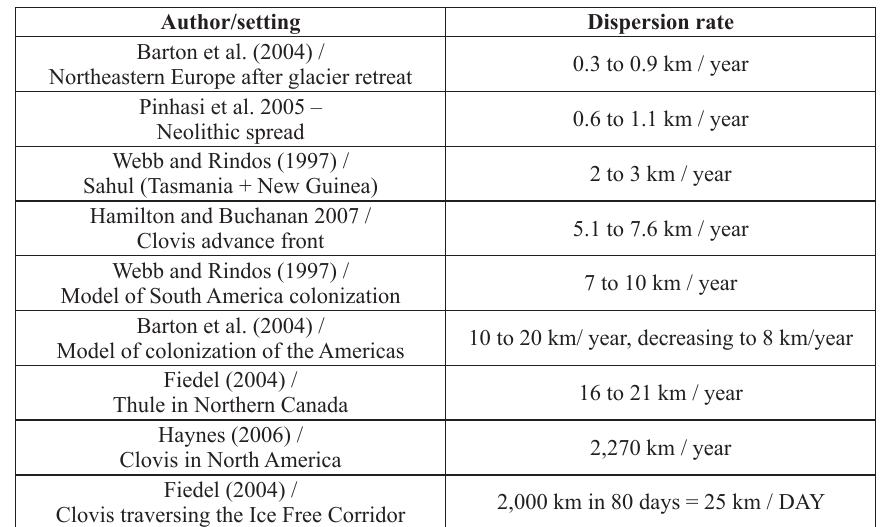
Estimates of dispersion rates for modern humans spreading in different